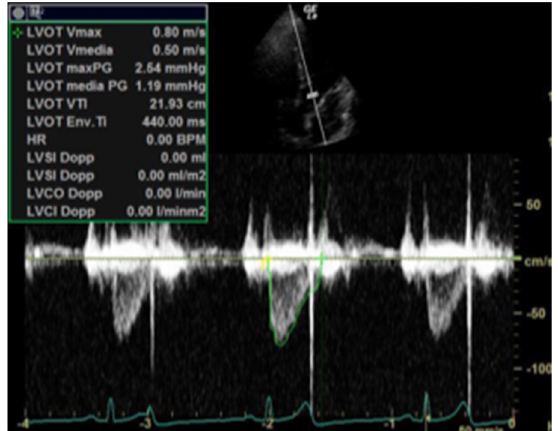
Figure 1. LVOT Velocity Time Integral (VTI), which is the distance the blood travels across the LVOT, calculated after tracing the LVOT pulsed − wave doppler.